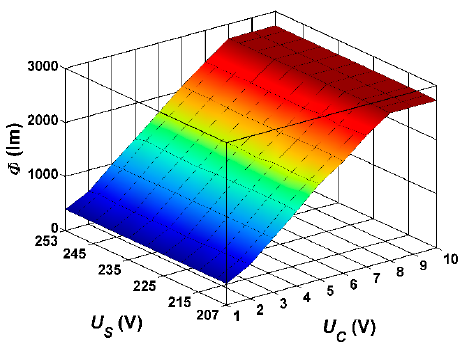
Figure 7. The relation of luminous flux Φ of the lighting luminaire as a function of supply voltage U S and control voltage U C .